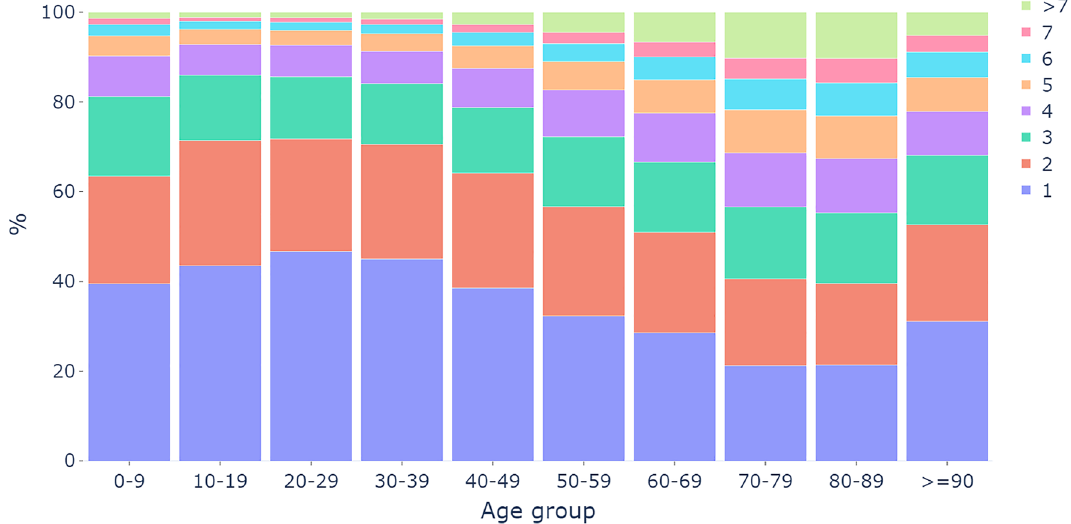
Figure 2. Number of differing diagnoses during 4-yr follow-up in age groups, with only diagnoses among the 100 most common